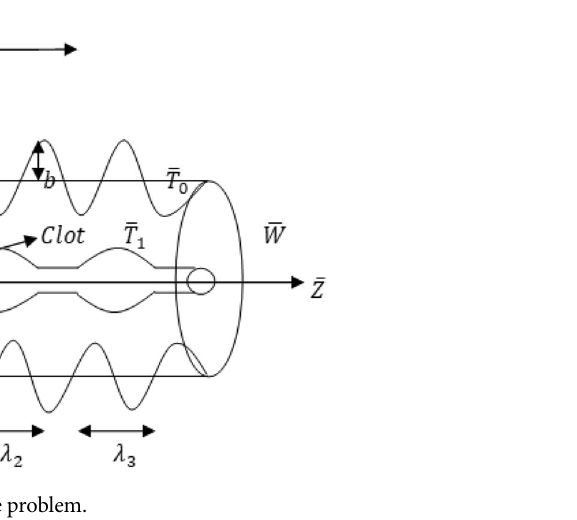
Figure 1. Geometry of the